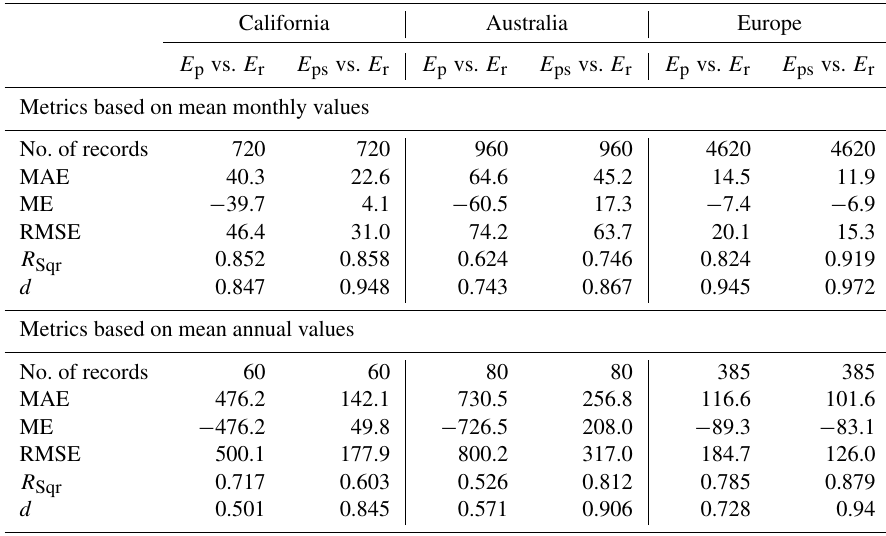
Table 1. Statistical metrics (Eqs. 12–16) for the comparisons between E p vs. E r and E ps vs. E r for CIMIS (California), AGBM (Australia), and ECAD (Europe) stations (the unit for MAE, ME, and RMSE is millimeters per month).